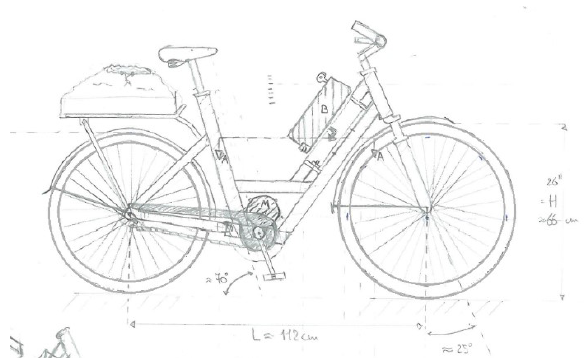
Figure 2. E-bike design: sketch by the writer, scale